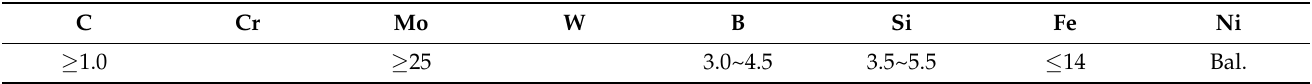
Table 1. Nominal chemical composition of Ni65 alloy powder (wt.%).